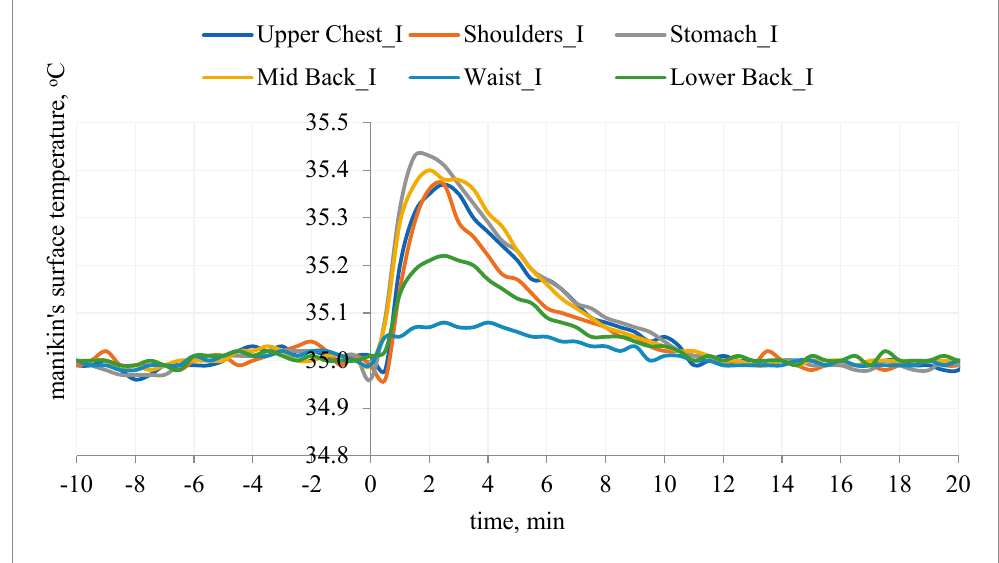
Figure 9. The manikin’s surface temperature after application of the undershirt without PCM (variant I).